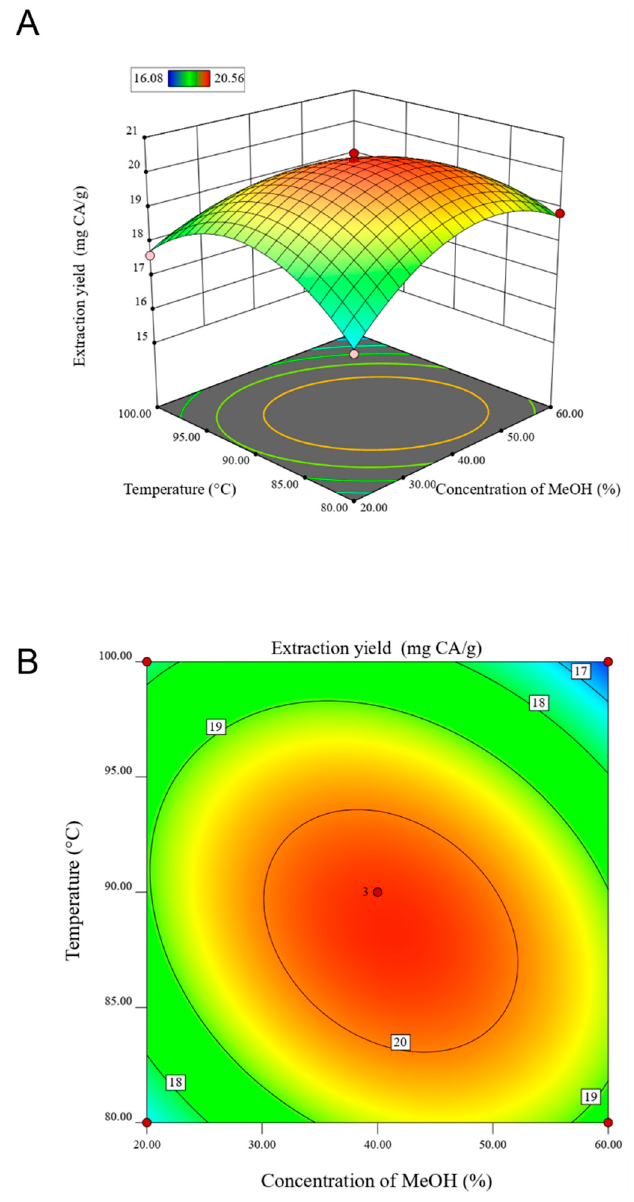
Figure 2. Response surface analysis based on solvent and temperature. ( A ) is the response surface graph and ( B ) is the corresponding contour graph.